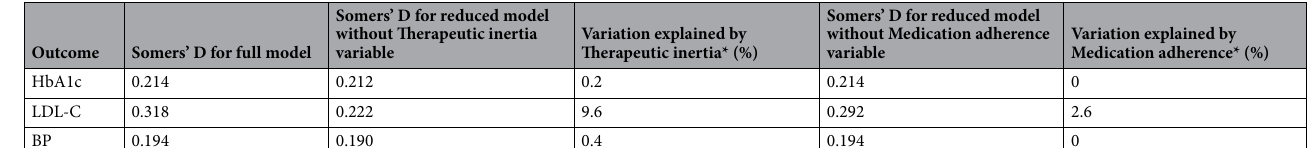
Variation explained by Therapeutic inertia* (%)